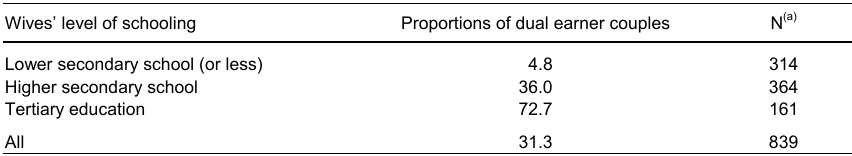
Tab. 4 Proportions of dual-career couples, aged 18-65, by wives’ level of school- ing. Italy 2001. Percentages Wives’ level of schooling Proportions of dual earner